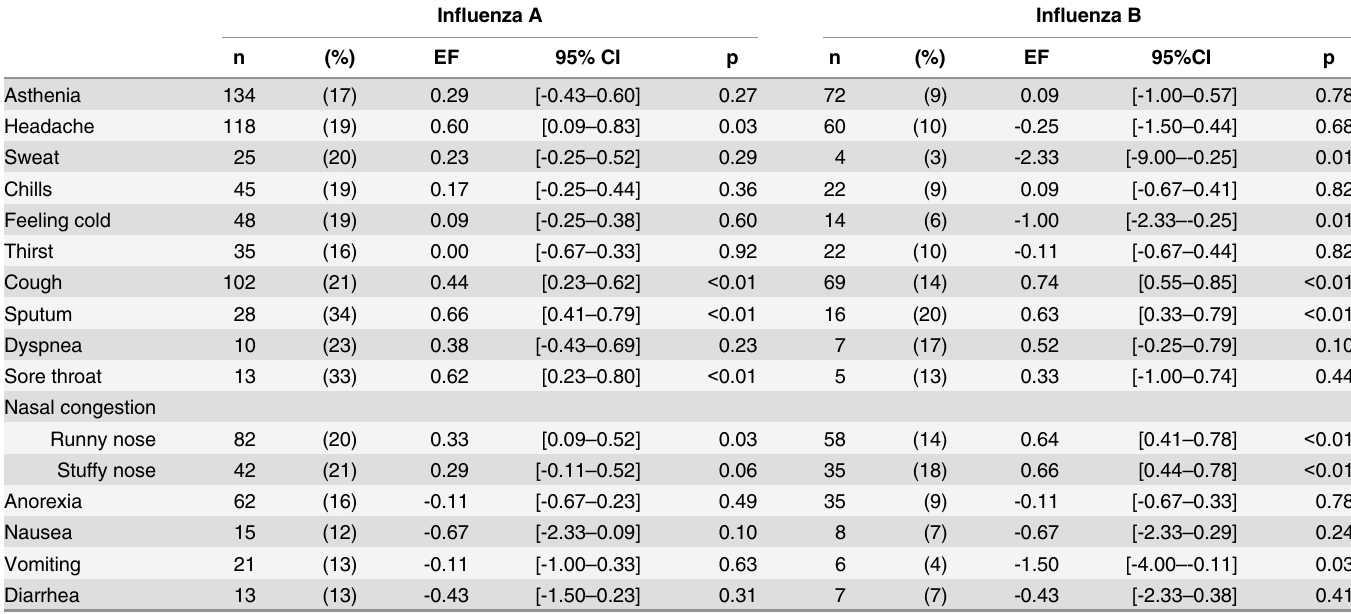
Table 3. Clinical symptoms associated with influenza infections in Dielmo and Ndiop, January 2012 – December 2013. In fl uenza A In fl uenza